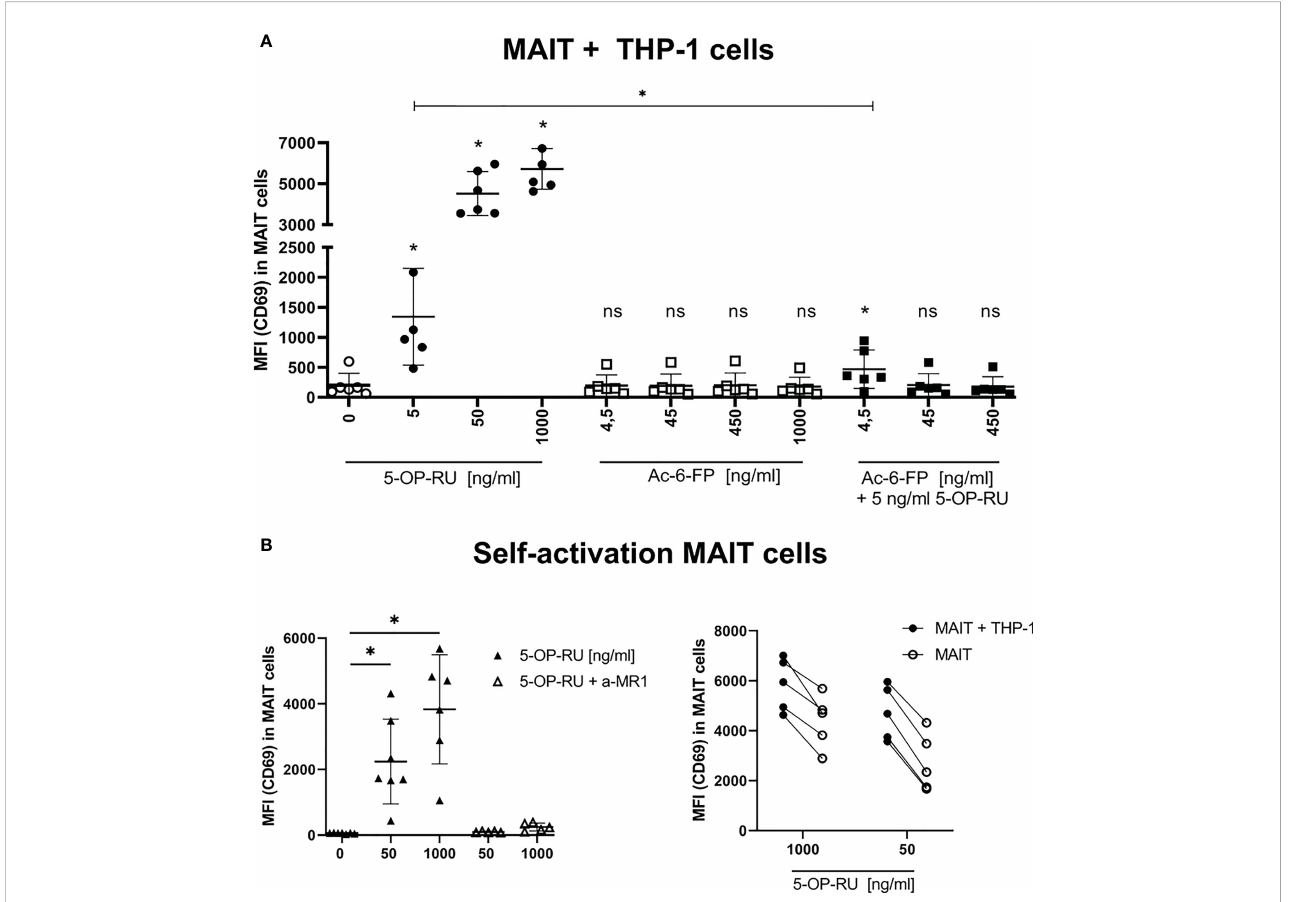
FIGURE 1 Metabolite-induced MAIT cell activation. (A) FACS-sorted primary human CD161 ++ V a 7.2 + CD3 + MAIT cells were paired with THP-1 cells (2:5 ratio) and stimulated with increasing concentrations of 5-OP-RU and Ac-6-FP for 20 hours at 37°C. For simultaneous stimulation with both metabolites, cells were pre-incubated for 1 hour at 37°C with varying concentrations of Ac-6-FP before 5 ng/ml 5-OP-RU were added. ( B , left) MAIT cells were stimulated without THP-1 cells with indicated 5-OP-RU concentrations. Anti-MR1 (a-MR1) was added 1 hour prior to stimulation and incubated at 37°C. ( B , right) Comparison of MAIT cell activation from bi- and mono-cellular system after stimulation with 5-OP-RU. Lines connect results from the same donors. ( A, B ) MAIT cell activation was quanti fi ed by fl ow cytometry determining the median fl uorescence intensity (MFI) of CD69 in live MAIT cells. Data from three independent experiments from six donors are shown. Asterisks indicate signi fi cant differences determined by Wilcoxon matched-pairs signed rank test: p* < 0.05. Horizontal lines indicate mean ± SD. ns, not signi fi